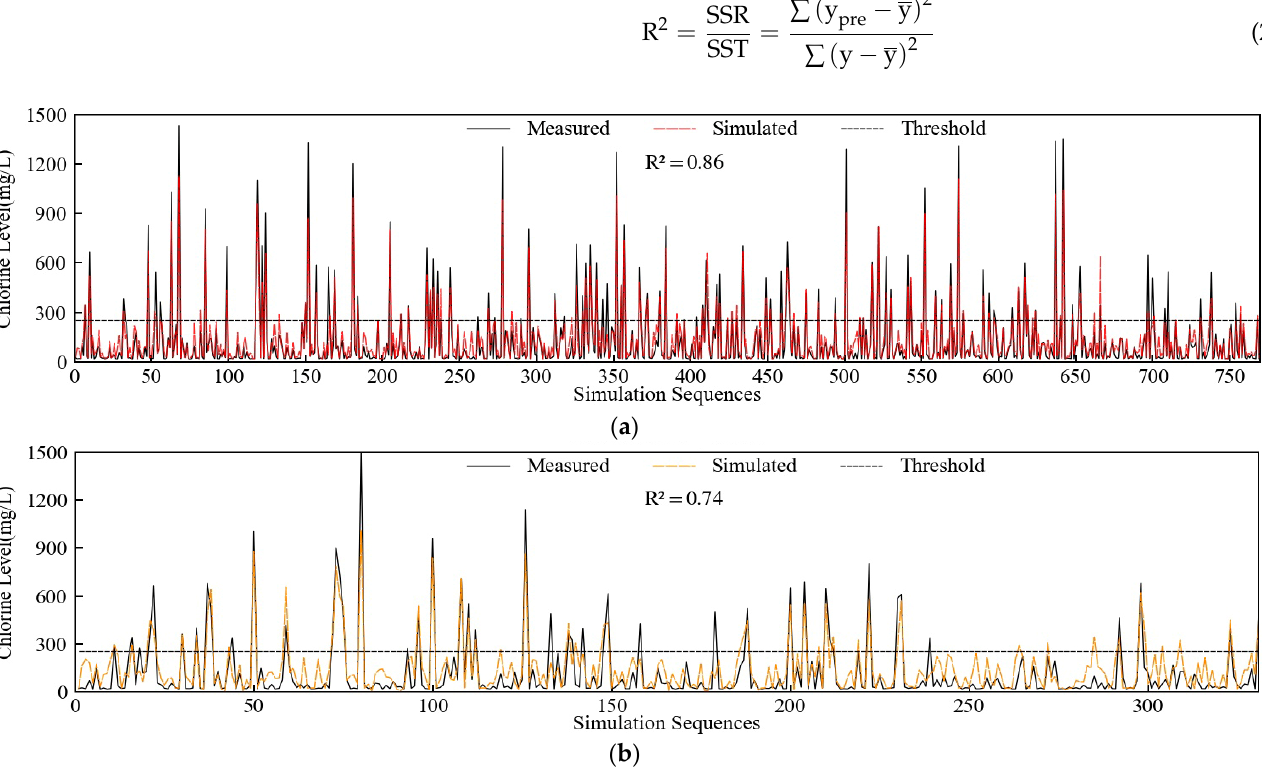
Figure 6. Simulation results: ( a ) Training datasets; ( b ) Test datasets.